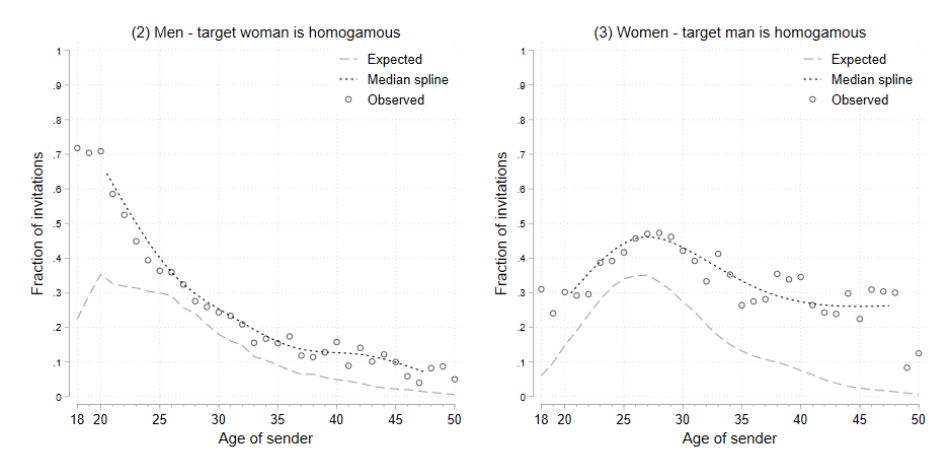
Figure 2 and 3 : Observed and expected fractions of initial messages sent to age- homogamous